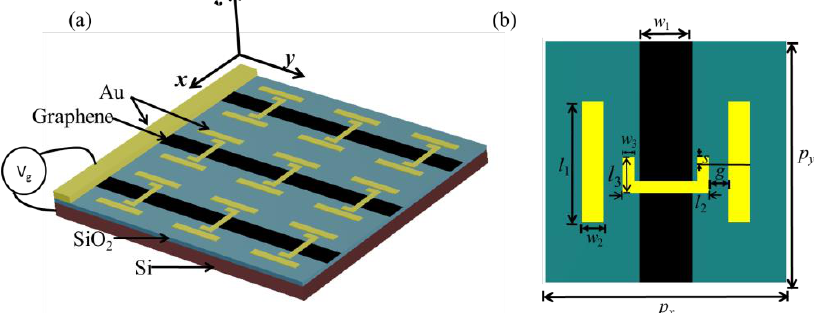
Figure 1. ( a ) The geometrical schematic of the proposed metal-graphene metamaterial and ( b ) the unit cell of the structure.